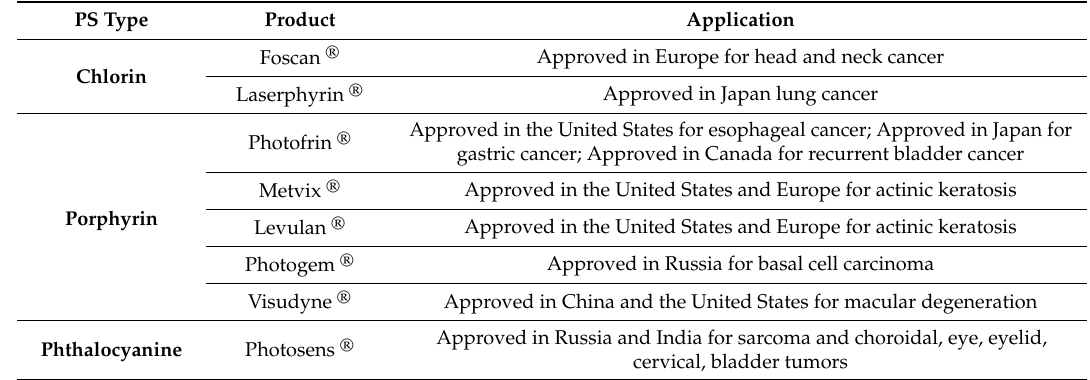
Table 1. Photosensitizers approved for clinical use. In this review, we summarize the investigations of the last 15 years using chlorin, phthalocyanine, and porphyrin derivatives as PS in the treatment of acne vulgaris, psoriasis, papilloma virus infections, cutaneous leishmaniasis, and skin rejuvenation, and discuss the mechanisms of PDT against these conditions and observe their clinical